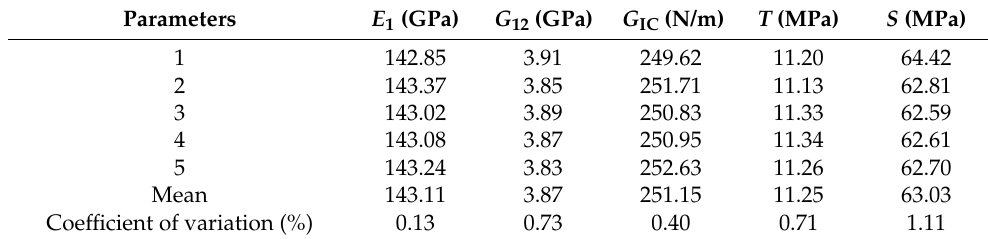
Table 3. The results of property identification conducted five times.